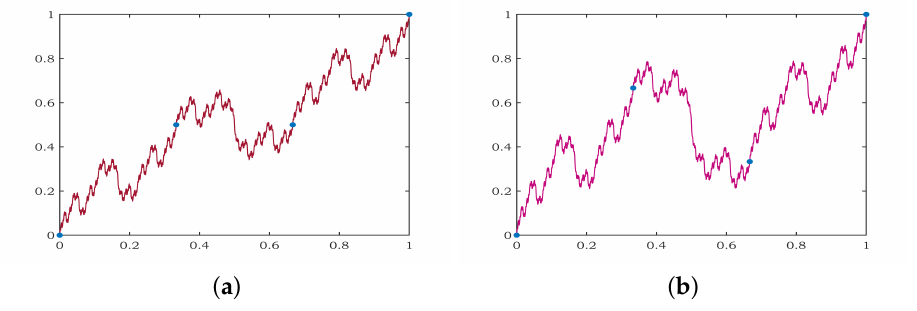
Figure 1. Hidden variable fractal interpolation function: ( a ) non-self-affine f 1 , ( b ) self-affine f 2